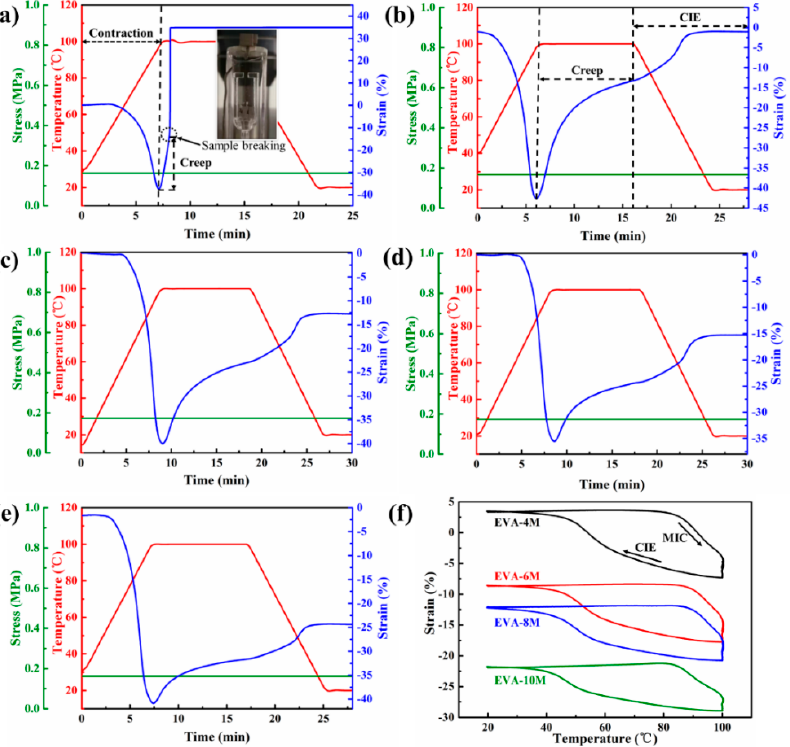
Figure 4. Thermal contraction and creep behavior under a constant stress of 0.17 MPa for ( a ) EVA-2M, ( b ) EVA-4M, ( c ) EVA-6M, ( d ) EVA-8M, and ( e ) EVA-10M. ( f ) Two-way shape memory effect (2W-SME) cycle curves of EVA fiber under a constant stress of 0.17 MPa with different UV curing time.